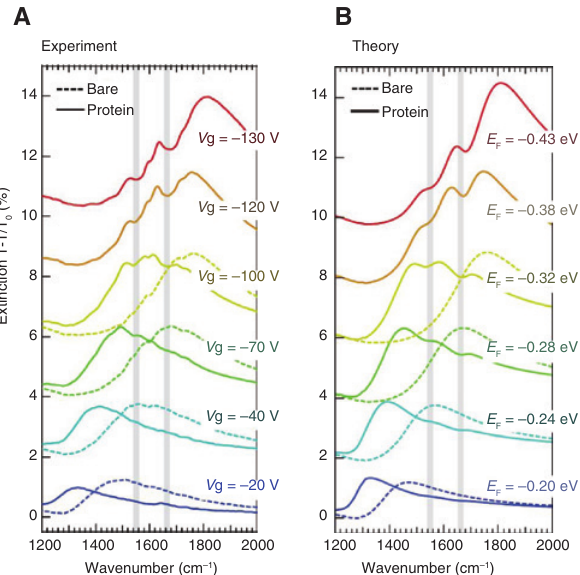
Figure 22: (A) Extinction spectra of the graphene nanoribbon array (W = 30 nm, P = 80 nm) for bias voltages V g from −20 V to −130 V before (dashed curves) and after (solid curves) protein bilayer formation. Extinction is calculated as the relative difference in trans- mission between regions with (T) and without (T ) graphene nanor- 0 ibbons. Gray vertical strips indicate amide I and II vibrational bands of the protein. (B) Analytic calculation of the extinction spectra after fitting graphene and protein parameters to reproduce experimental data. Adapted with permission from Ref.